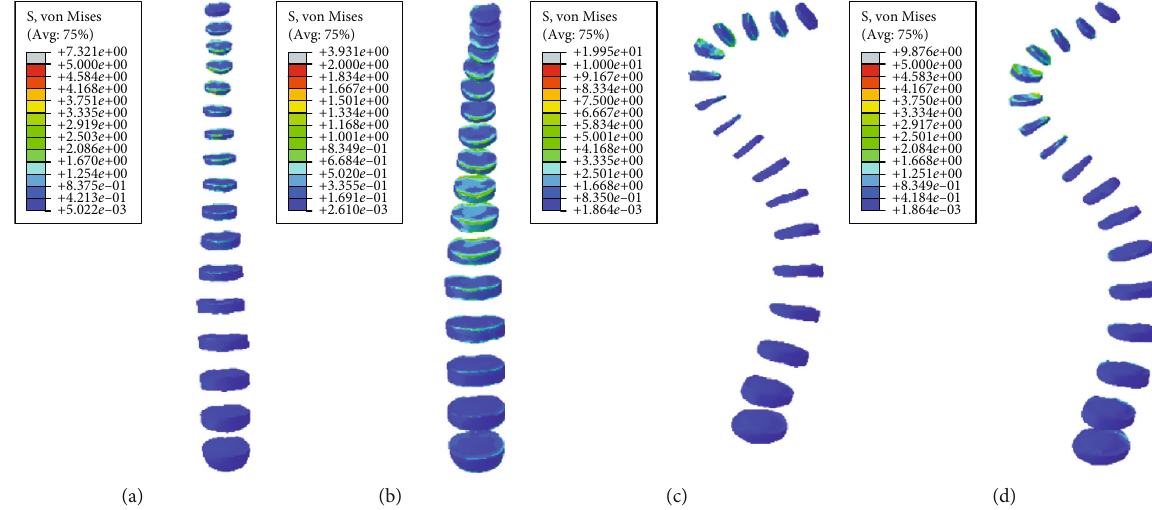
Figure 12: von Mises stress distribution of disc in four spinal models under vertical compression: (a) normal spine without rib cage (NS1); (b) normal spine with normal rib cage (NS2); (c) scoliotic spine without rib cage (SS1); (d) scoliotic spine with deformed rib cage